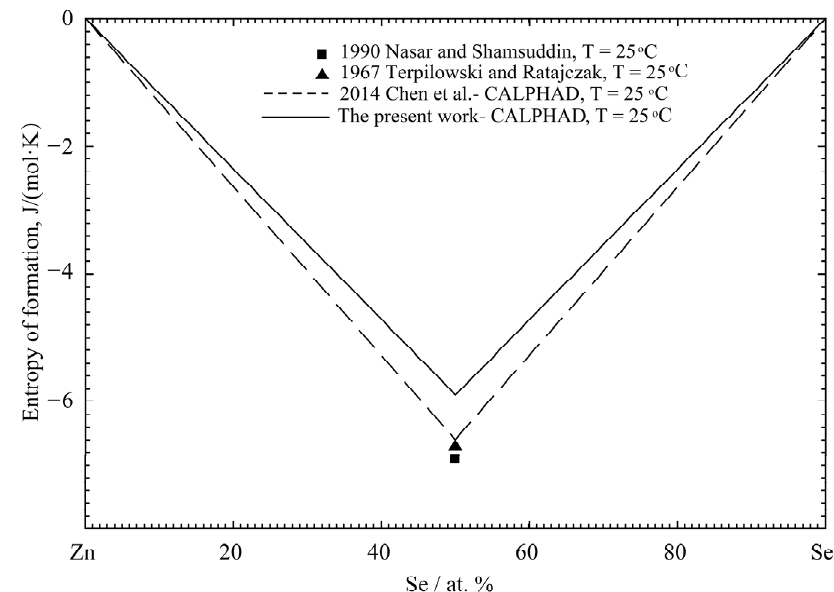
Figure 17. The calculated standard entropy of formation at 25 °C in the Zn-Se system compared with the experimental data from refs. [118,123] and previously optimized results by Chen et al. [125].